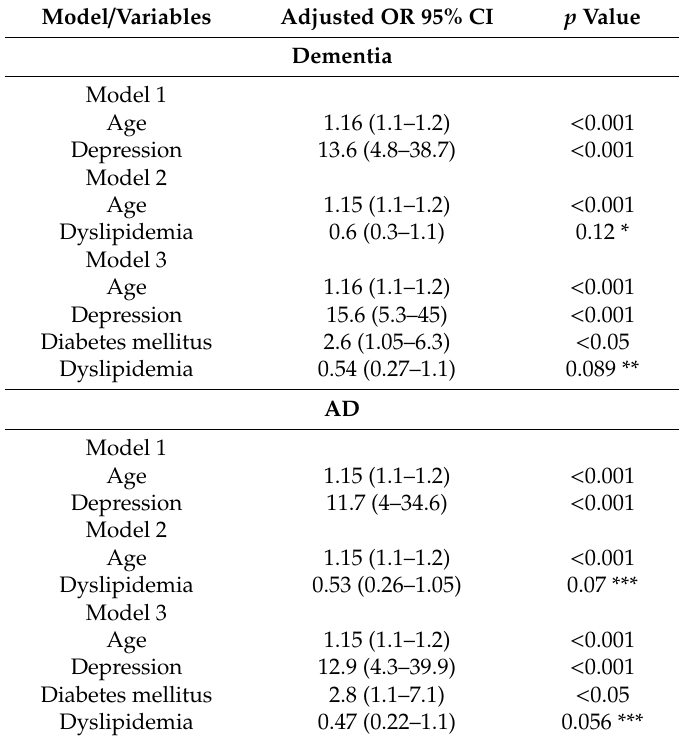
Table 3. Adjusted logistic regression models for dementia and AD outcome